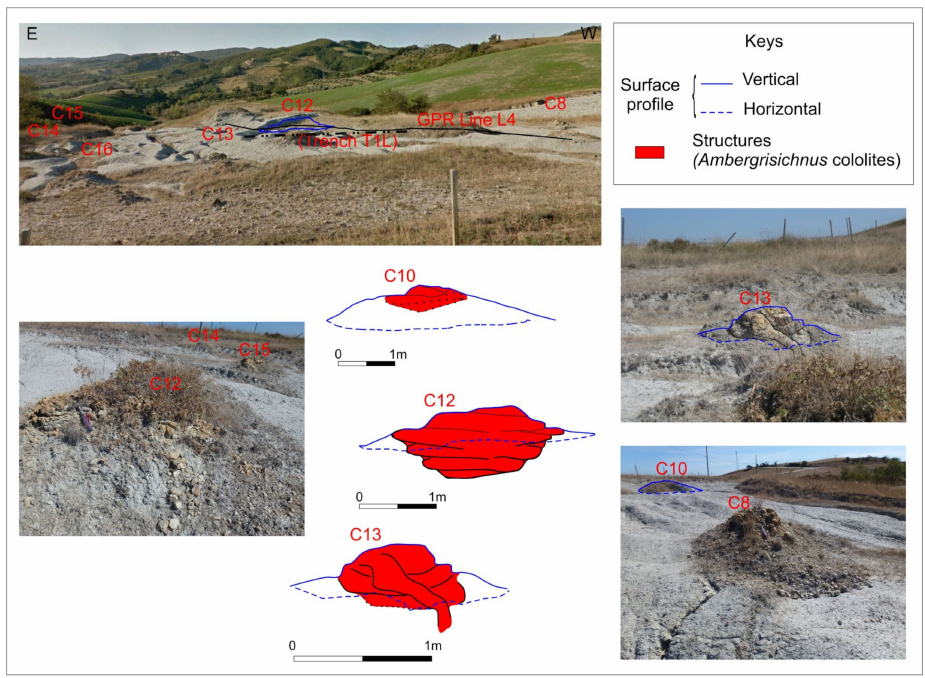
Figure 5. Shape and size of main Ambergrisichnus cololites along selected GPR lines, trenches, and excavation